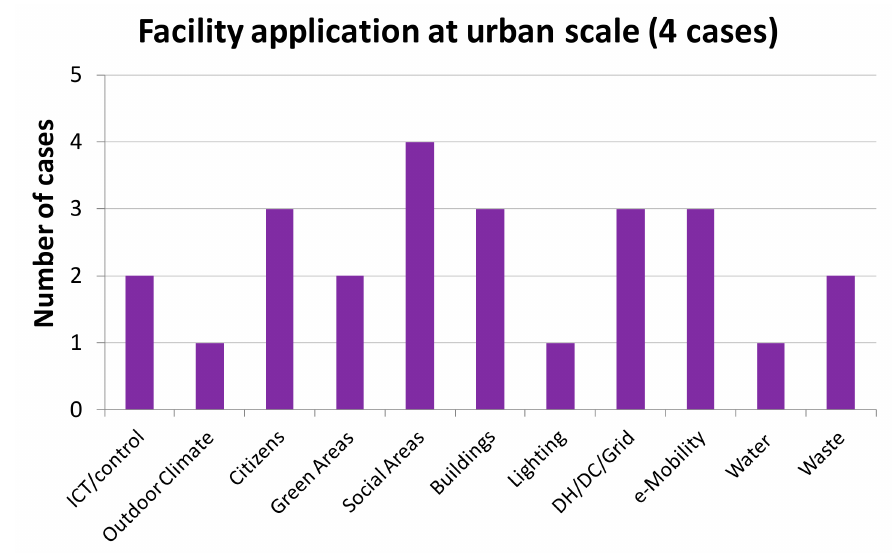
Figure 15. Histogram of occurrence obtained for the facility applications at the urban scale.